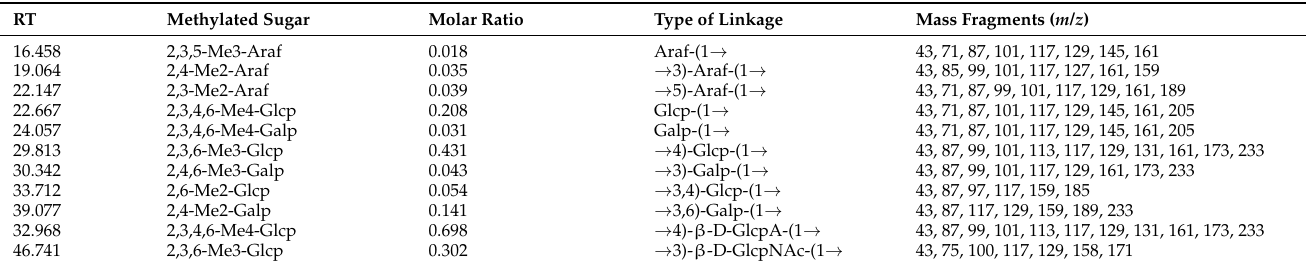
Figure 3. Total ion chromatogram of F1 ( A ) and F2 ( B ). Table 2. Linkage types of F1 and F2.